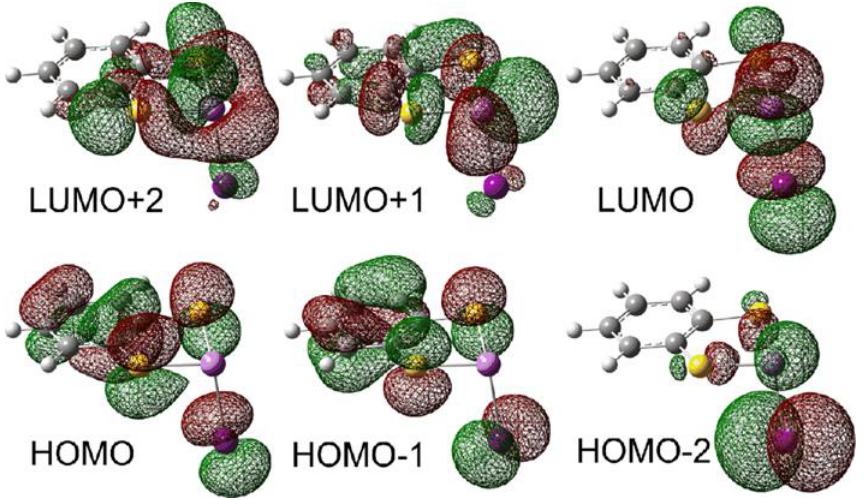
Figure 8. Orbital contours of the lowest energy transitions for 1 as representative of all studied compounds. Table 4. DFT (B3LYP / IEFPCM) calculated compositions of selected highest occupied and lowest unoccupied molecular orbitals of studied compounds in dichloromethane, expressed in terms of composing fragments (X – I (for 1 and 3 ) or Br ( 2 and 4 ); L B —bidentate ligand: PhS 2 ( 1 and 3 ) or MePhS 2 ( 2 and 4 )).